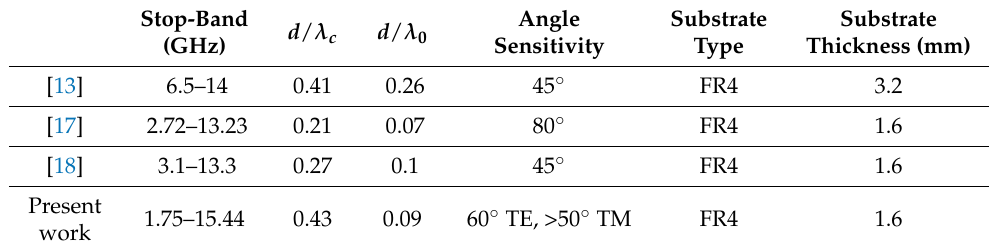
Table 3. Comparison with other